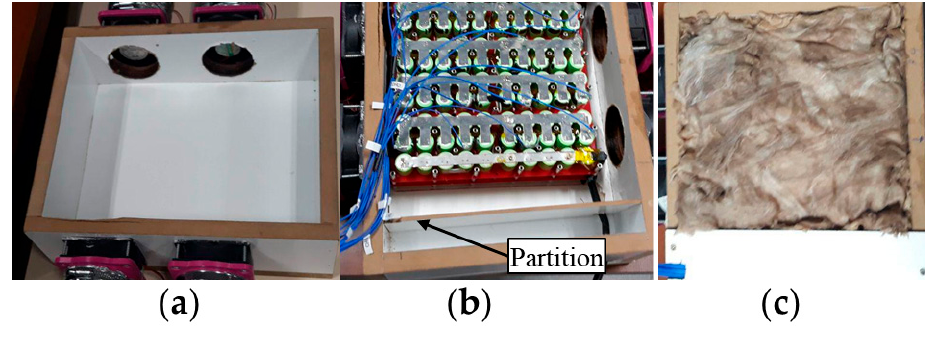
Figure 6. Battery box design.